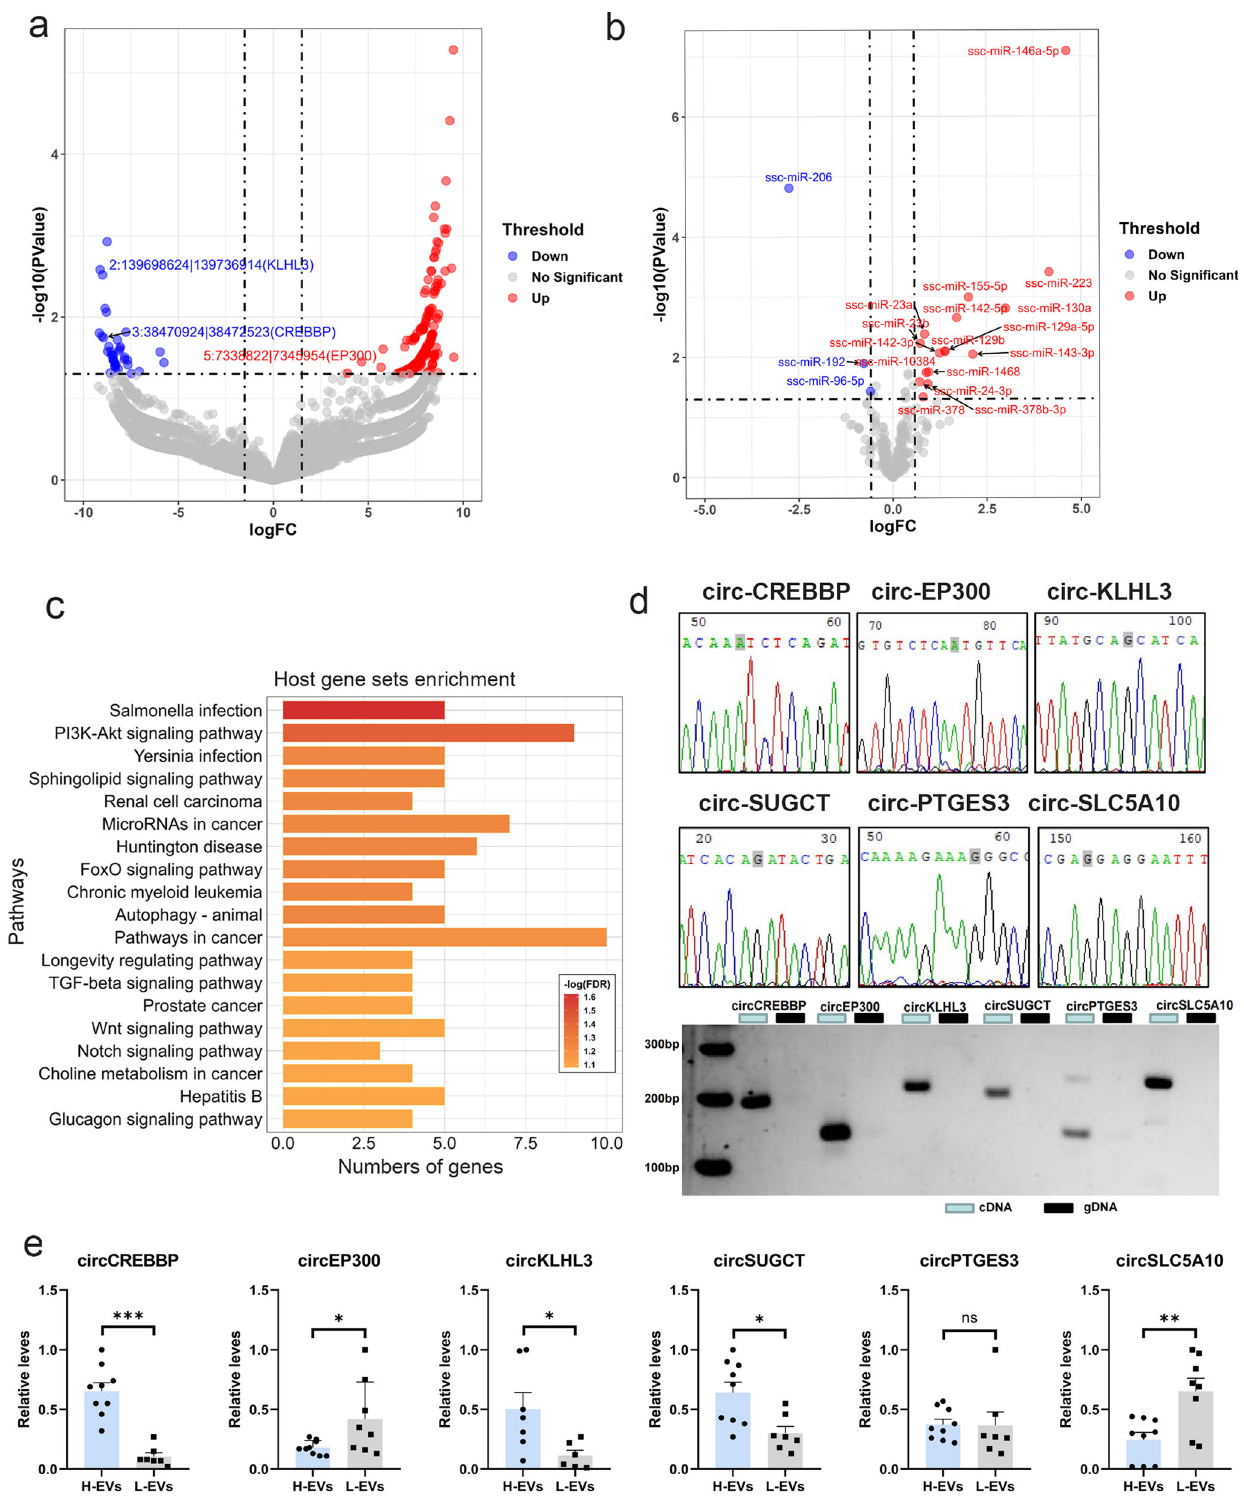
Fig. 3 Whole-transcriptome pro fi les of the H-SPEV and L-SPEV groups. a Volcano plot of DECs. Red represents upregulation in the L group, and blue represents upregulation in the H group. b Volcano plot of 19 DEMs. Red represents upregulation in the L group, and blue represents upregulation in the H group. c KEGG pathway analysis of host genes of DECs. d The back-splice junction sites of six circRNAs were validated by qPCR followed by Sanger sequencing. The junction sites of circRNAs are marked in gray. e qPCR validation results for six circRNAs in the two groups. Data are presented as the mean ± SEM. * P ≤ 0.05, ** P ≤ 0.01, *** P ≤ 0.001 (Student ’ s t test), n = 3 for each